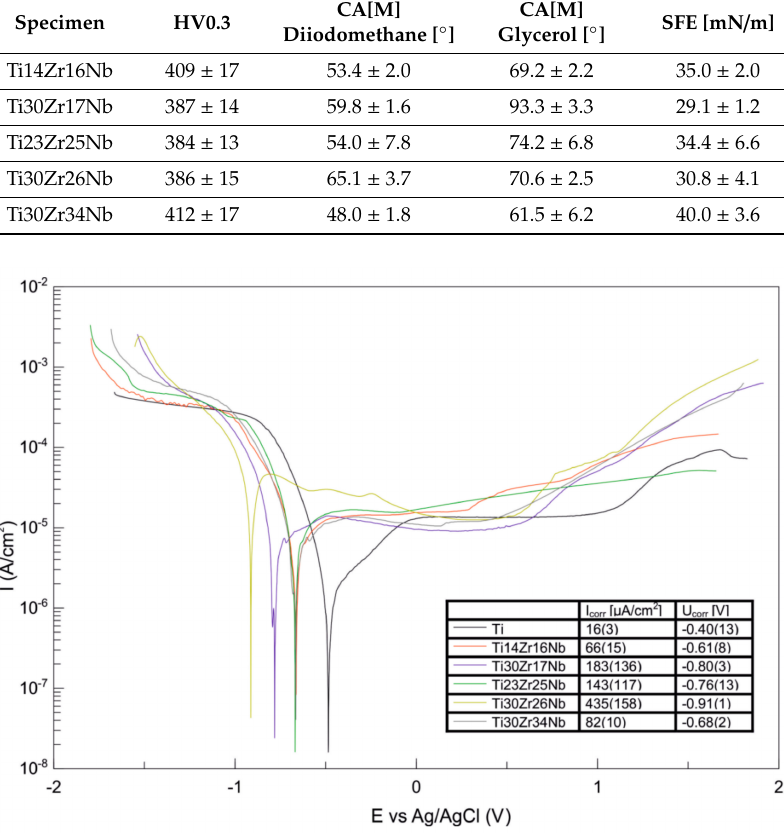
Figure 8. Potentiodynamic curves of bulk β and pseudo- β alloys Ti30Zr17Nb, Ti23Zr25Nb, Ti30Zr26Nb, Ti30Zr34Nb cold pressed and sintered at 750 ◦ C for 30 min in comparison with dual-phase Ti14Zr16Nb processed in the same conditions. The results were obtained from the group of three replicated